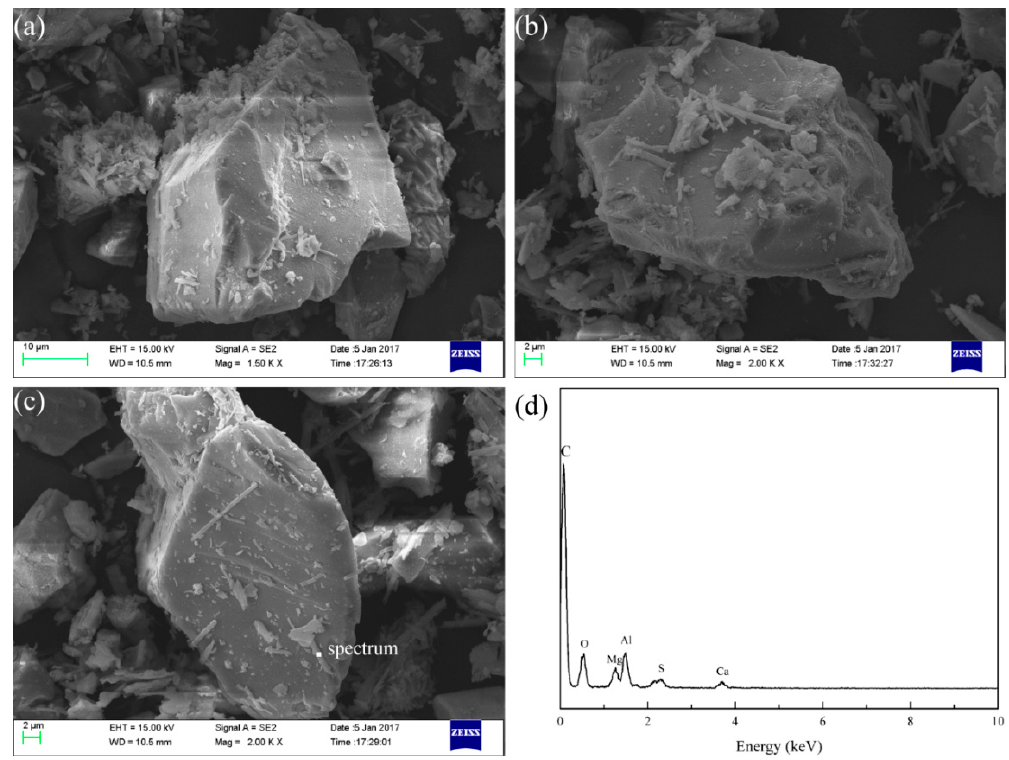
Figure 14. Scanning electronic microscopy (SEM) micrograph of perovskite ( a ), Titanaugite ( b ), MA-spinel ( c ), and EDX spectrum of needles coated on minerals’ surfaces ( d ).